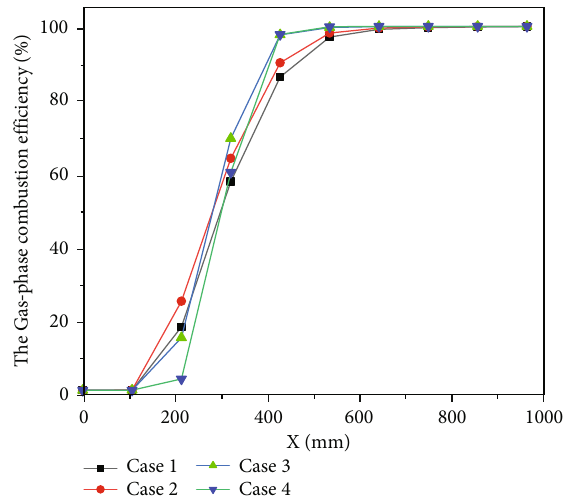
Figure 12: The gas-phase combustion e ffi ciency in each cross section of the